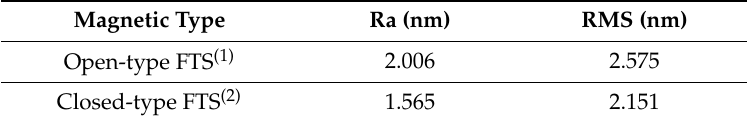
Table 2. Surface roughness values of prepared ITO